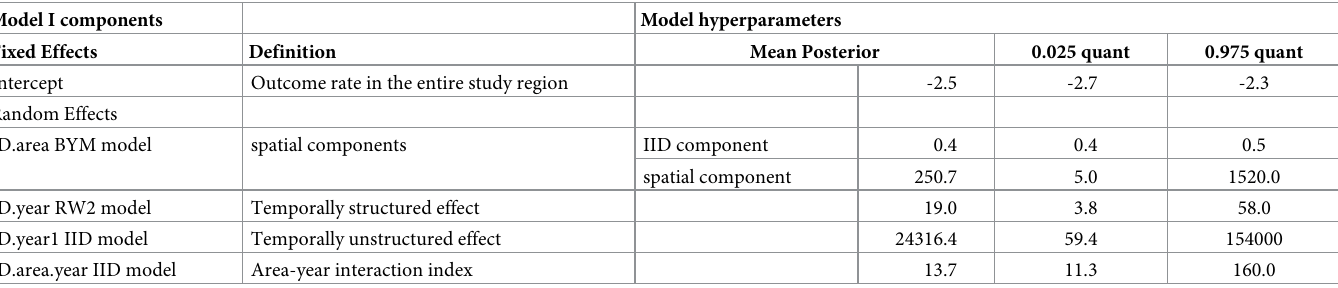
Table 2. Results of the nonparametric spatiotemporal model (model 1) without space-time interaction effects. Model I